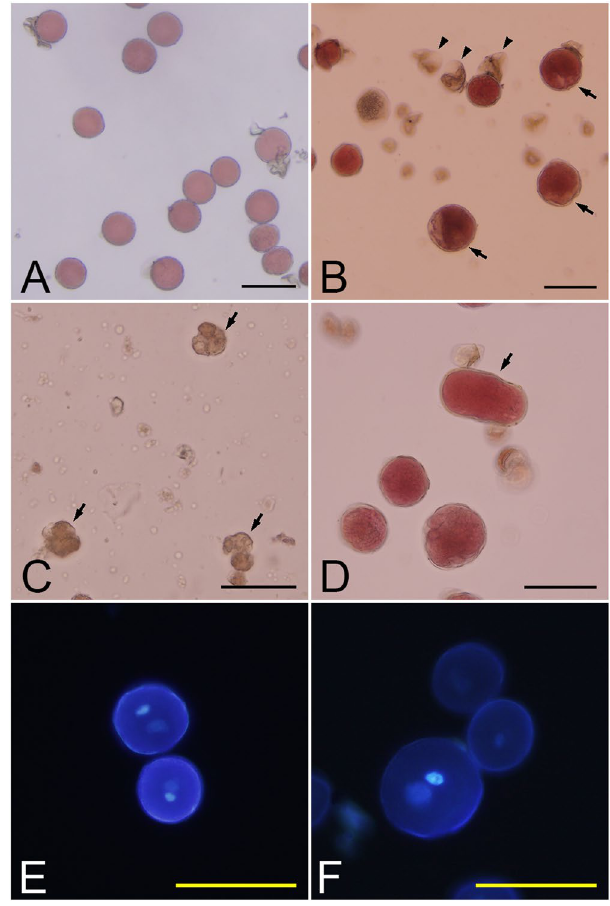
Figure 1. High temperature-induced pollen and untreated control pollen. ( A ) Pollen collected from untreated buds; ( B ) High temperature-induced pollen, showing large pollen grains (arrows) and aborted pollen grains (arrow heads); ( C ) Tetrad shaped aborted grains failed in cytokinesis (arrows); ( D ) Conjoined grains failed in microspore segregation (arrow); ( E ) Control pollen with DAPI staining; ( F ) High temperature-induced pollen with DAPI staining, showing a large grain with large gametophytic nuclei. Bars = 50 μ m.